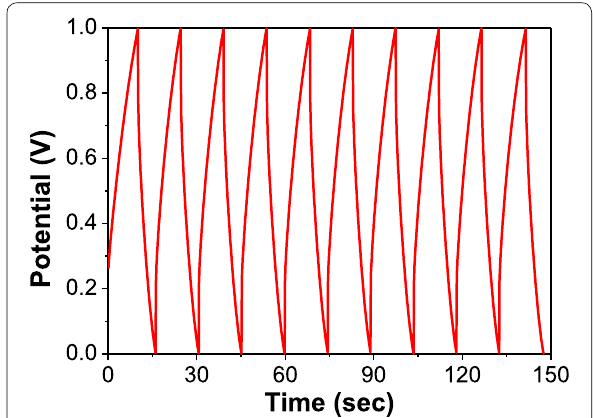
Fig. 7 Galvanostatic charging–discharging (GCD) curve under current of 10 mA